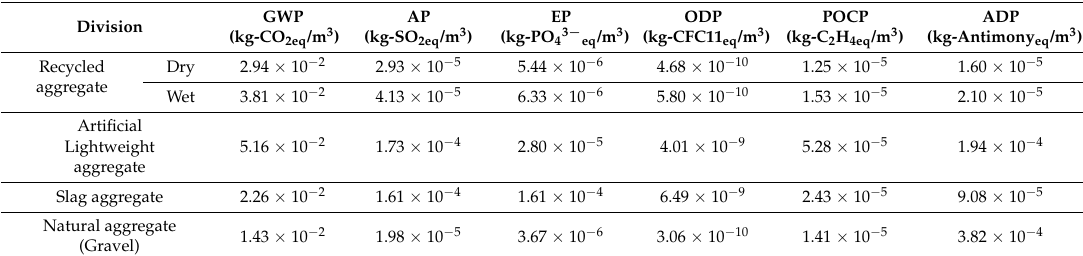
Table 5. Environmental impact comparison by aggregate type.